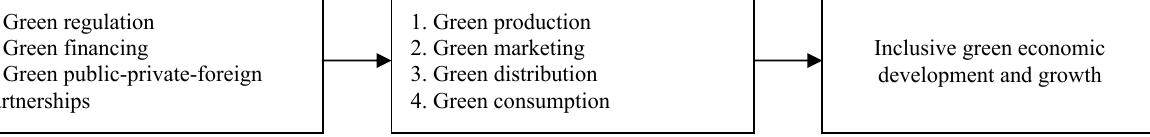
Fig. 3. Proposed model of inclusive green